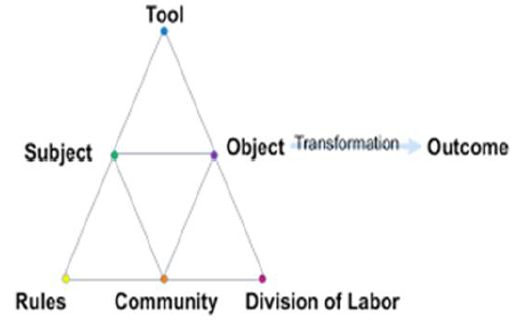
Figure 1: Cultural Historical Activity Theory (Engeström, 1987)